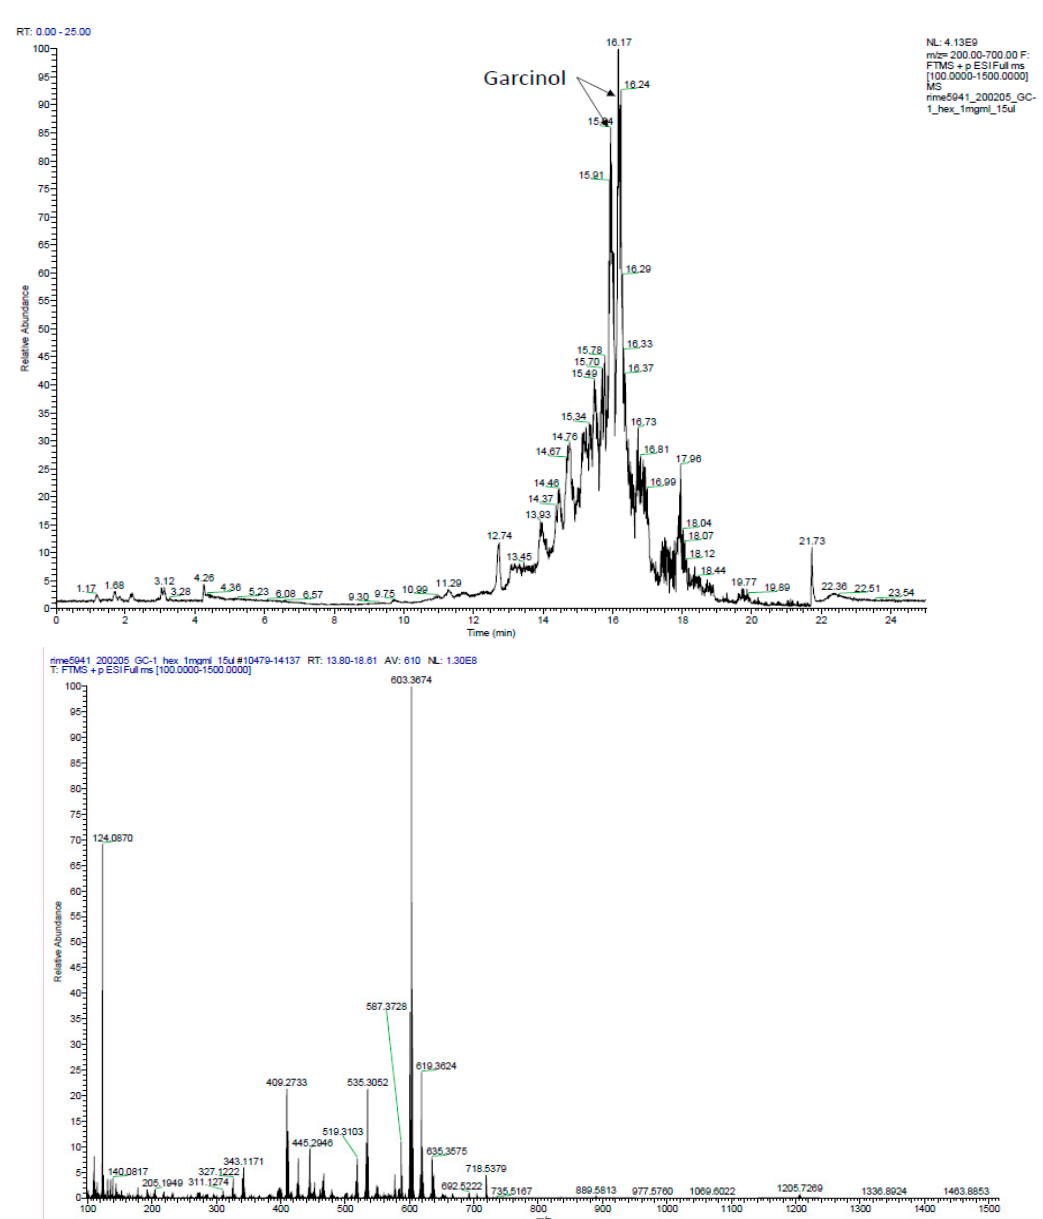
Figure A1. UPLC-MS analysis of the n -hexane extract of G. cambogia indicating the presence of garcinol.